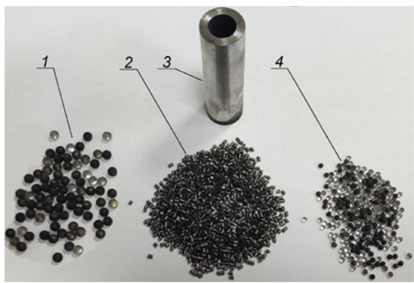
Figure 3. Comparison of the sizes of: 1—4 mm glass balls, 2—NC1214 propellants, 3—sleeve, 4—2 mm glass